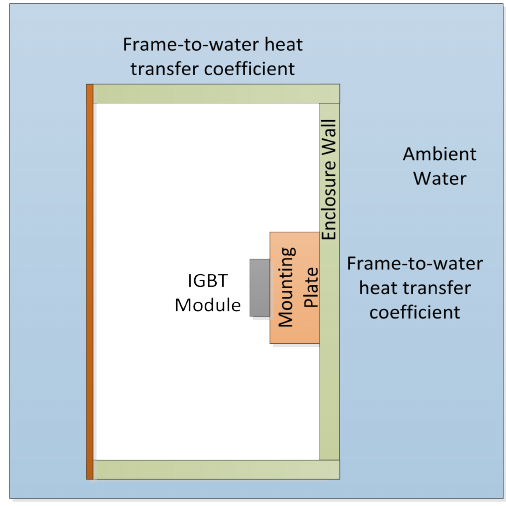
Figure 2. Power electronic module in a submerged and hermetically-sealed power converter